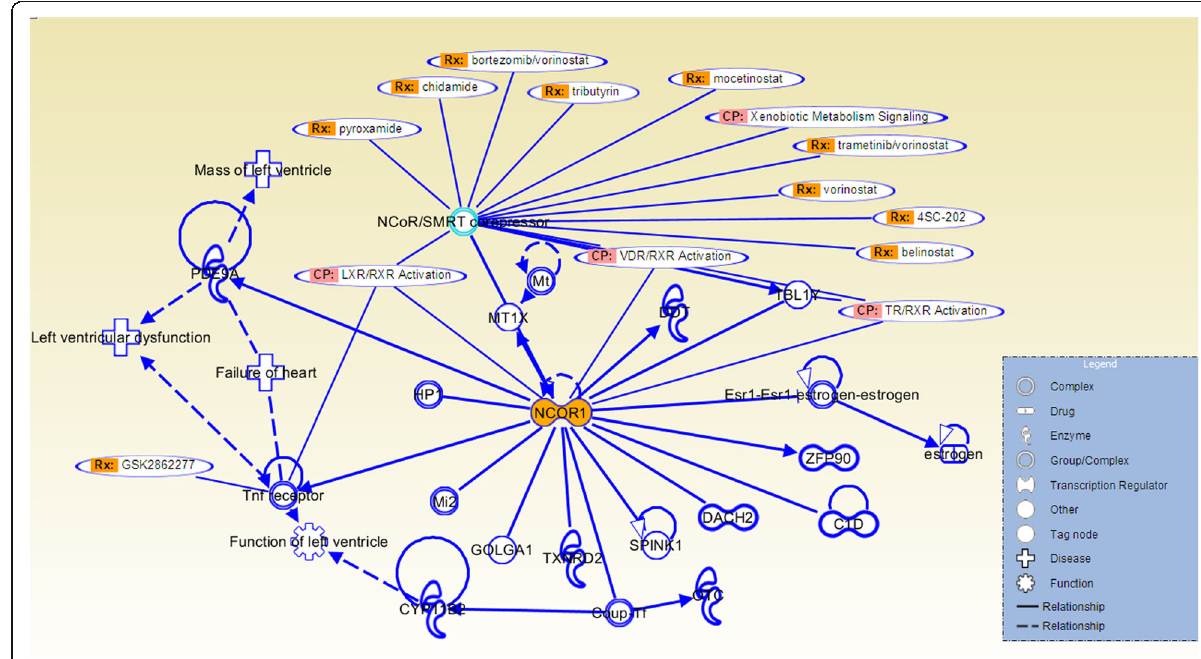
Fig. 4 Pathway analysis in the VSD cases. When NCOR1 protein is affected, the product of the PDE9A enzyme does not get activated and thereby impairs the downstream cascade for PDE9A. PDE9A as a protein can no longer regulate natriuretic peptide that fails to stimulate and regulate cyclic guanosine monophosphate (cGMP) in heart myocytes. It leads to a series of complexities resulting in left ventricular